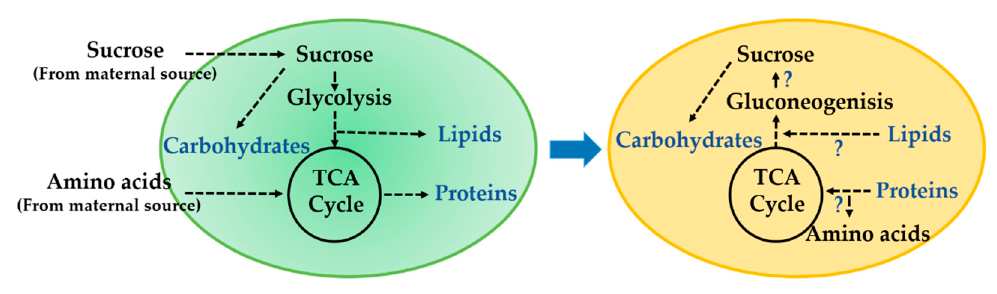
Figure 1. Drawing showing hypothetical shift in carbon partitioning from seed filling to maturation phase. During seed filling (R5–R7), central carbon (C) and nitrogen (N) sources (i.e., sucrose and amino acids) from maternal tissue are distributed to lipids, carbohydrates, and proteins through glycolysis, tricarboxylic acid (TCA) cycle, and amino acid metabolic pathways. As the seed transitions to maturation phase (R7 to R8), some accumulated proteins are degraded by proteolysis, while lipids are degraded via β -oxidation and potentially used for raffinose family oligosaccharide (RFO) biosynthesis through gluconeogenesis.